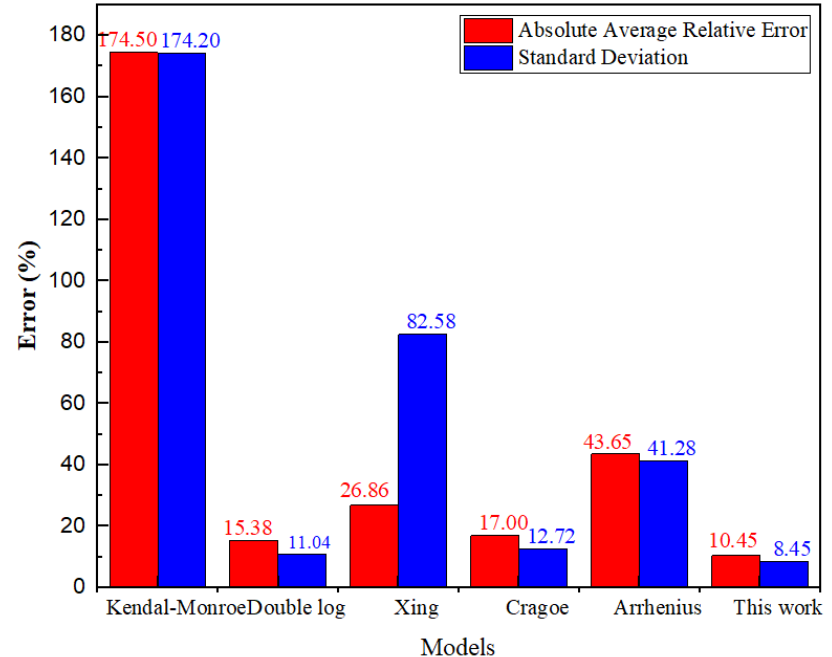
Figure 10. Comparison of the AARE and SD for the various models.